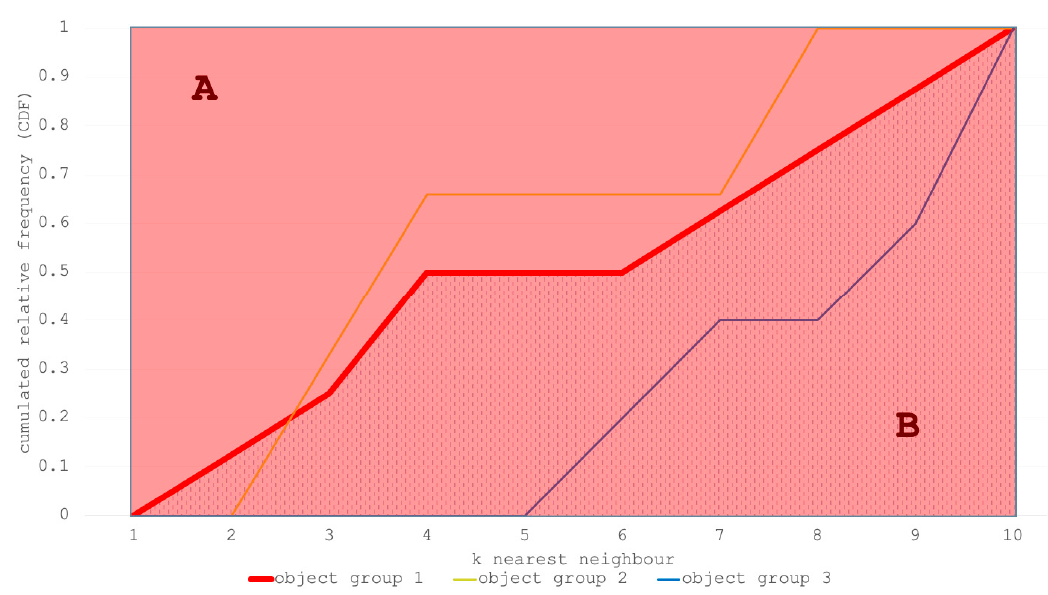
Figure 6. The idea of the spatial dispersion index is to consider the area below each graph ( B , dashed) in relation to the total area ( A , red). Shown is the example for the area below the red graph (object group 1).